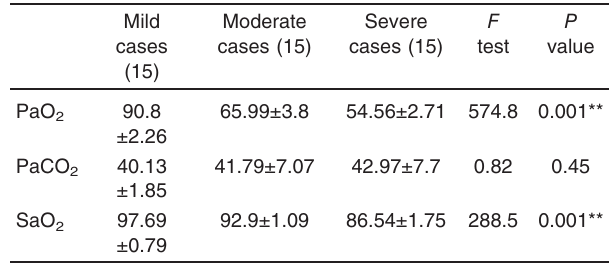
Table 3 Comparison between the studied groups according to partial pressure of oxygen in arterial blood, partial pressure of carbon dioxide in arterial blood, and oxygen